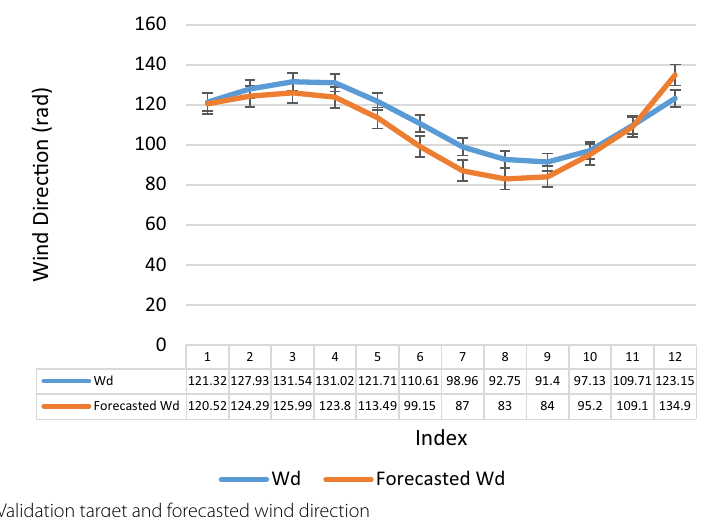
Fig. 30 Validation target and forecasted wind direction